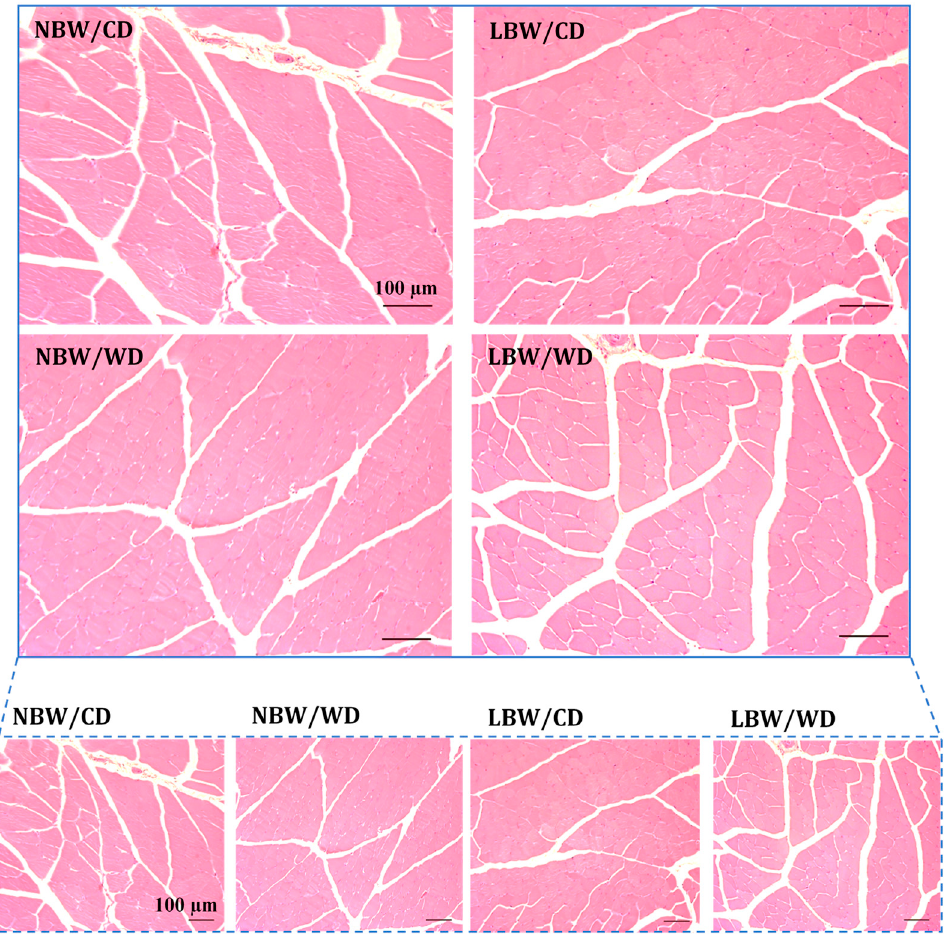
Figure 5. Hematoxylin and eosin ( H&E) staining of gastrocnemius muscle. Gastrocnemius was isolated from 145-day-old guinea pigs. Cross sections (5 µm) from 5–9 animals/experimental group were stained with H&E to identify lipid vesicles. Representative fields are shown at low and high magnification are displayed. Interstitial adipocytes were not present for any treatment group and, therefore, were not quantified. Scale bar = 100 µm.